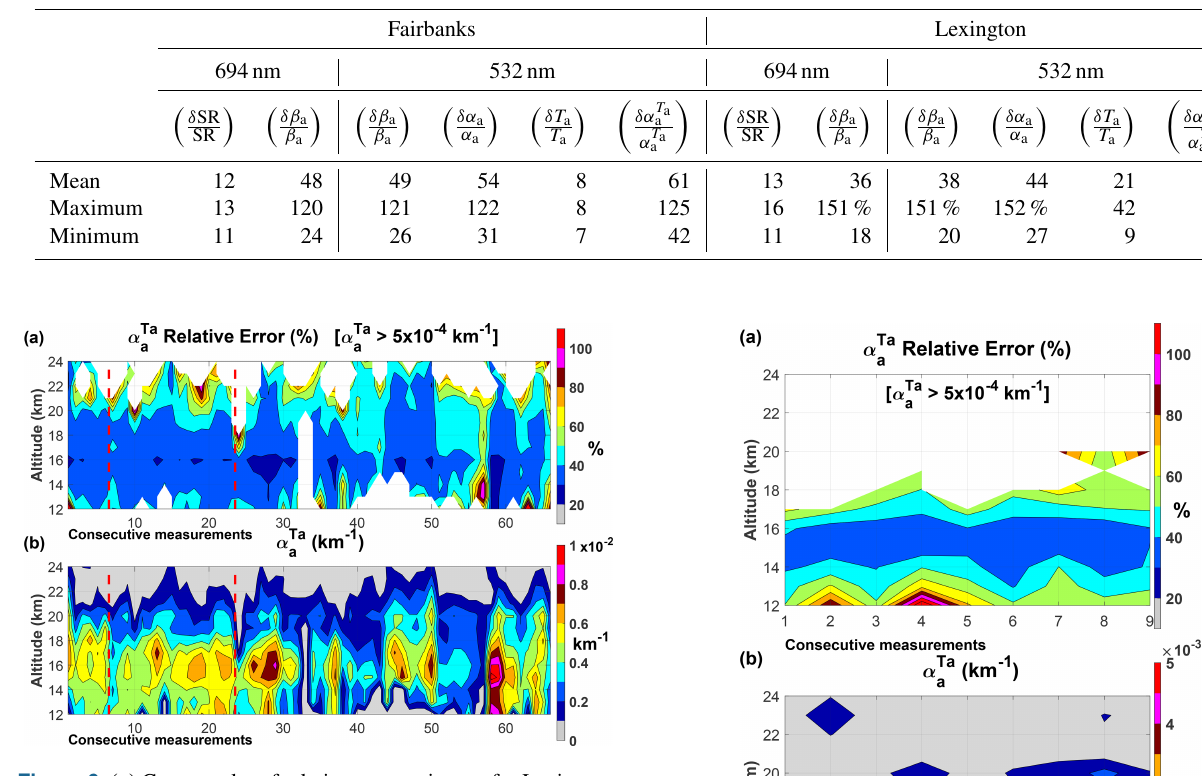
Figure 9. (a) Contour plot of relative error estimates for Lexington. (b) Contour plot of the aerosol extinction at 532nm corrected by two-way transmittance for Lexington . Note the two data gap peri- ods greater than 1 month for the consecutive measurements: March, and July to September both in 1964. They are identified with ver- tical dotted red lines at the 7th and 23rd measurements. In the top panel the areas in white in the relative error contour plot represent relative errors for α T a a ≤ 5 × 10 − 4 km − 1 . They were not included in the statistics in Table 4. Figure 10. The same as Fig. 9 but for